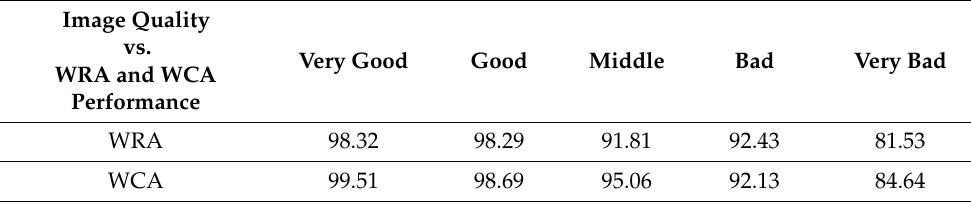
Table 4. The test results of a comprehensive benchmarking of our model (for text recognition) with different document-image quality levels of our test